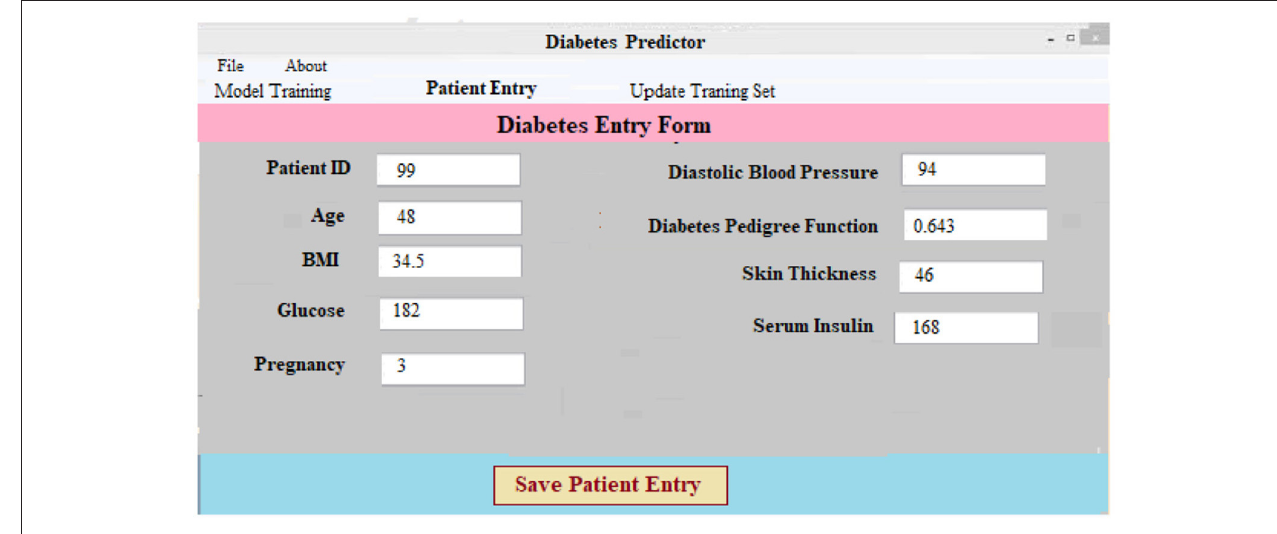
FIGURE 5 | Data entry form for diabetes prediction.